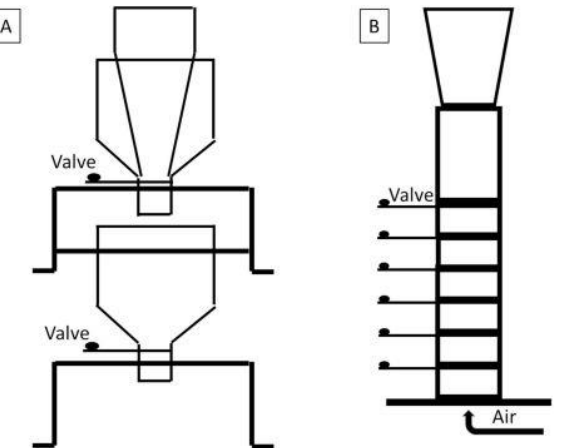
Figure 2. Schematic representation of segregation testers: ( A ) sifting; ( B ) fluidization. The depicted fluidization assembly is a modified version of the ASTM tester with 3 additional compartments. Adapted with permission from [21]; published by Elsevier, 2019.